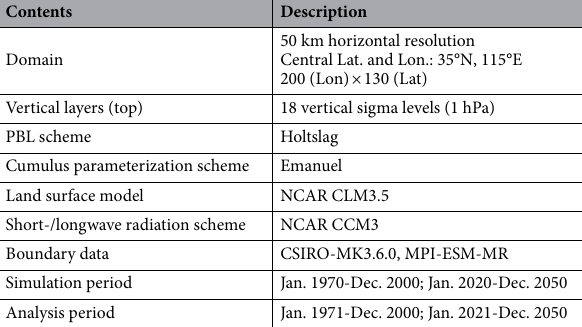
Table 1. The RegCM4 model configuration used in this study.